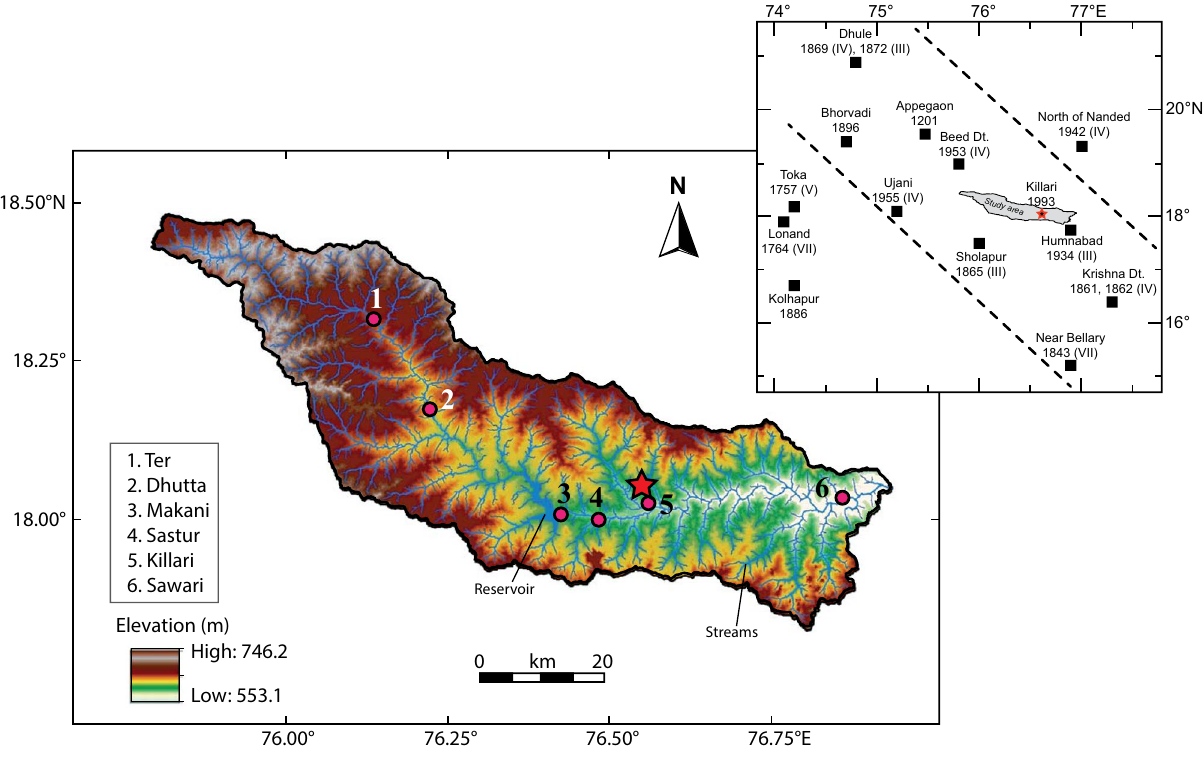
Figure 2. Digital elevation model (DEM) of Tirna River basin (Source: http://srtm.csi.cgiar .org) and inset map shows location of historic earthquakes around Killari (modified after Jain et al 2 and Rajendran et al 5